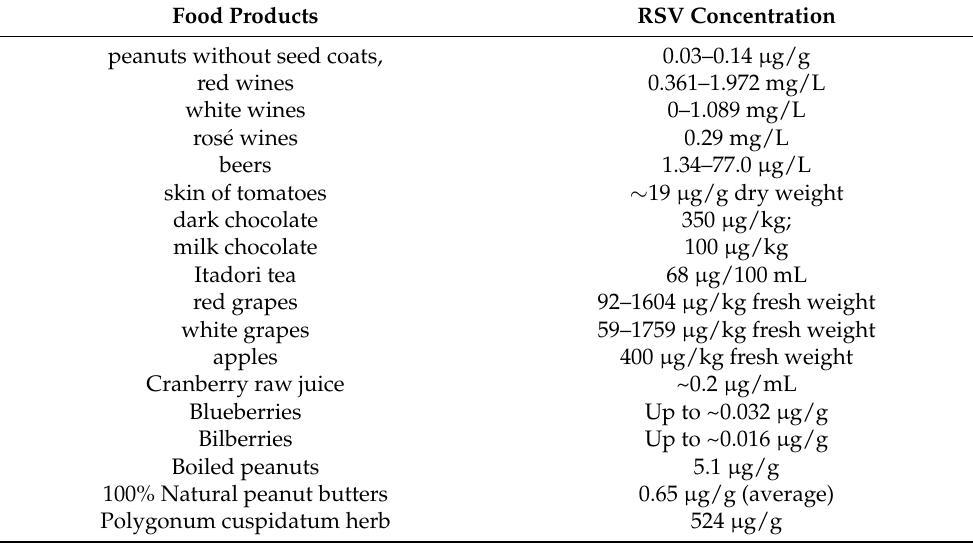
Table 1. Resveratrol concentration in food